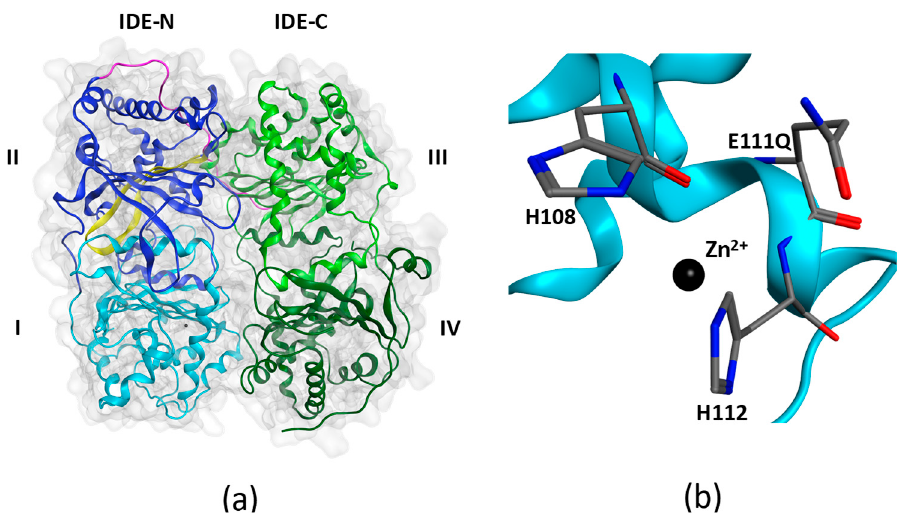
Figure 1. X-ray structure of insulin-degrading enzyme in its closed conformational state (PDB: 4PES). ( a ) IDE is composed of an N-terminal half (IDE-N) containing domains I and II, and a C-terminal half (IDE-C) containing domains III and IV. The two halves are joined by an unstructured linker (magenta). Domain I contains the HXXEH zinc-binding and catalytic motif. Domain II contains the exosite (yellow) in an anti-parallel β -sheet conformation. ( b ) The HXXEH motif includes H108 and H112 that coordinate Zn 2+ and the catalytically important glutamate (E111) residue. When E111 is mutated to a glutamine as in 4PES, the enzyme becomes inactive.